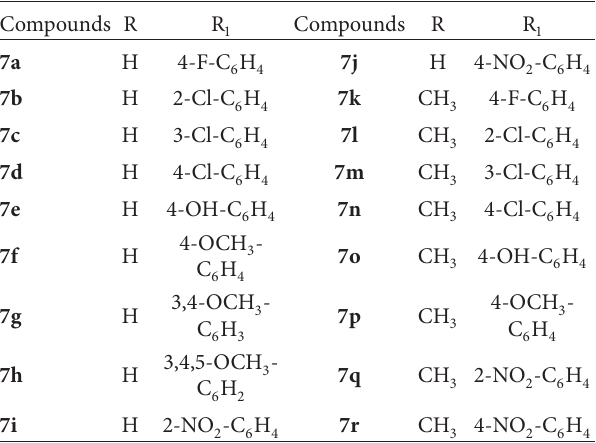
Table 1: List of compounds prepared 7a – r .